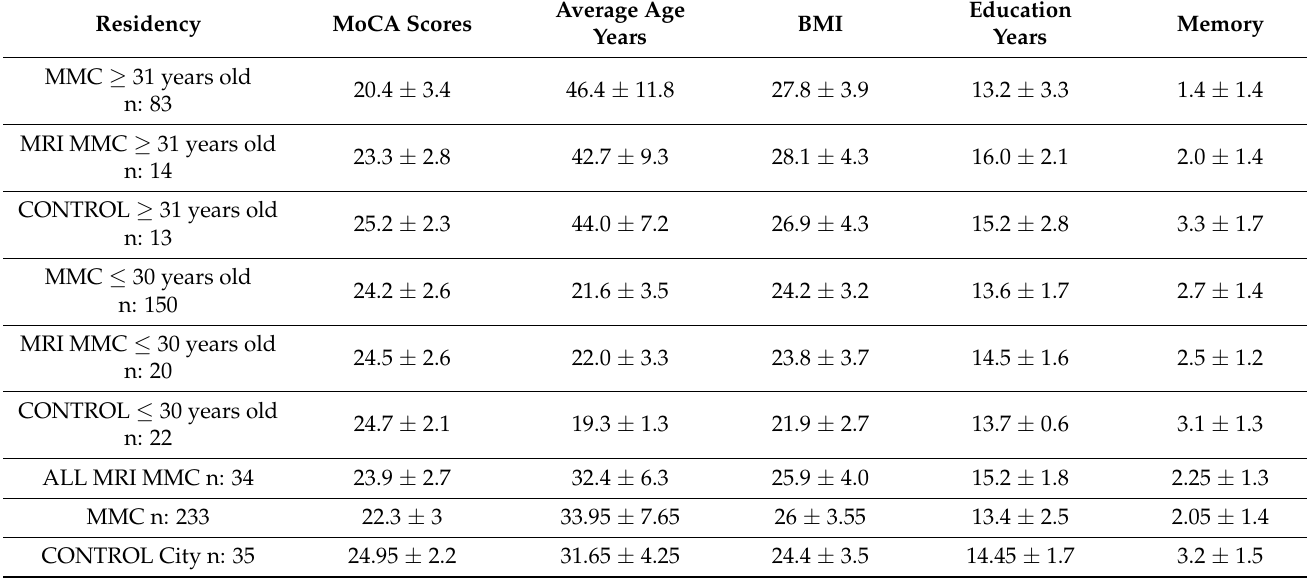
Table 1. Summary of MoCA scores, age, BMI, formal education years and memory score in the MMC 233 subjects, the control city of Hermosillo 35 group versus the MMC MRI + MoCA 34